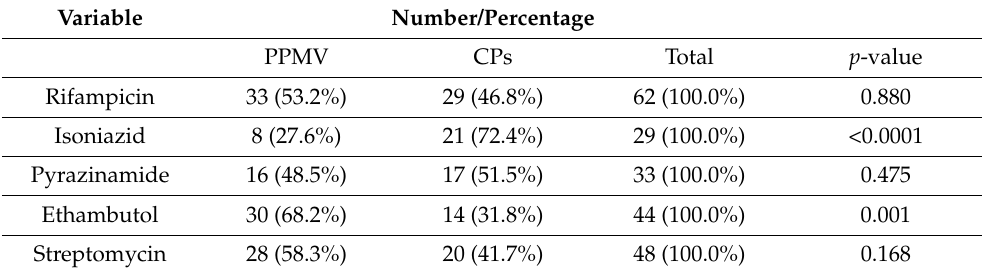
Table 2. Type of anti-TB medications stocked by CPs and PMVs, n =